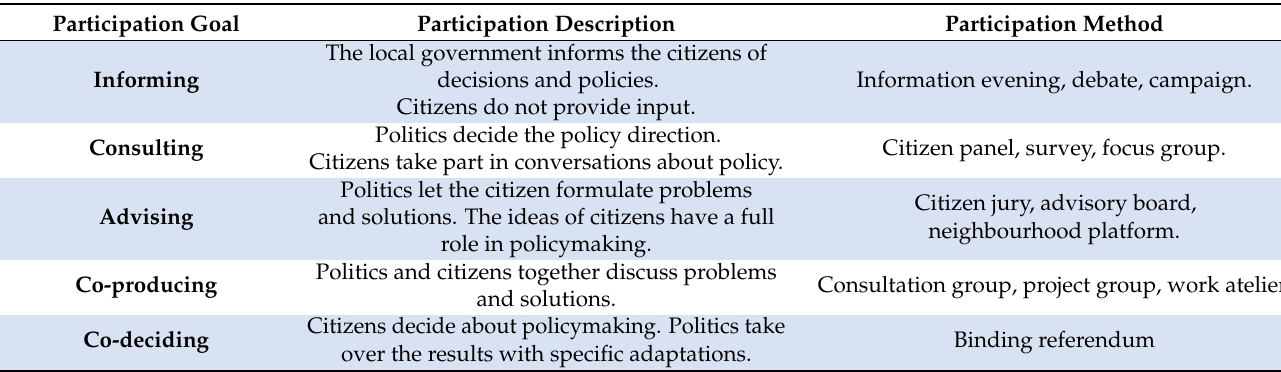
Table 1. Citizen participation goals and